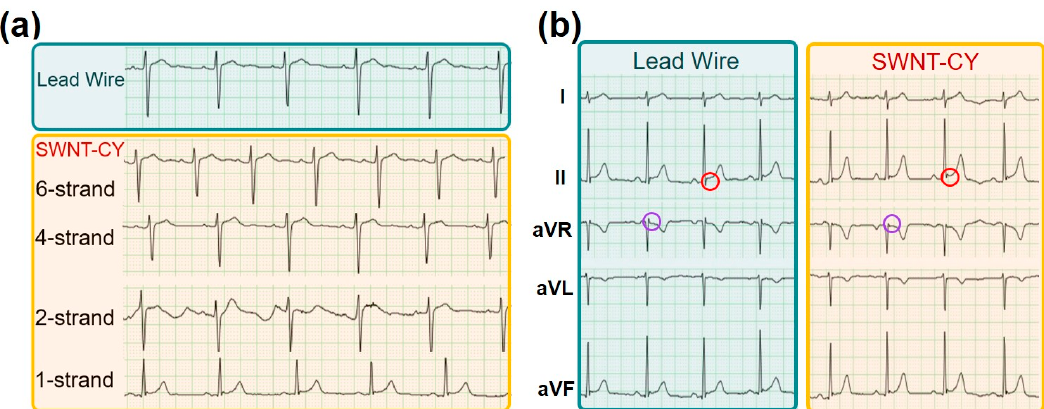
Figure 6. ( a ) ECG signals of V1-lead recorded from the same subject (20 years old, male) using commercial lead wires (area in light blue) and SWNT-CYs (area in light yellow, connecting the V1 electrode and the host machine); and ( b ) a comparison of ECG signal recorded by metal-based lead wires and 4-strand SWNT-CYs (connecting the RA electrode and the host machine). All these ECG signals were obtained from the empirical ECG signals acquired by the pre-installed filter of the measurement system. The gap between two horizontal green lines represents 500 mv, while the distance between the vertical green lines represents 200 ms.